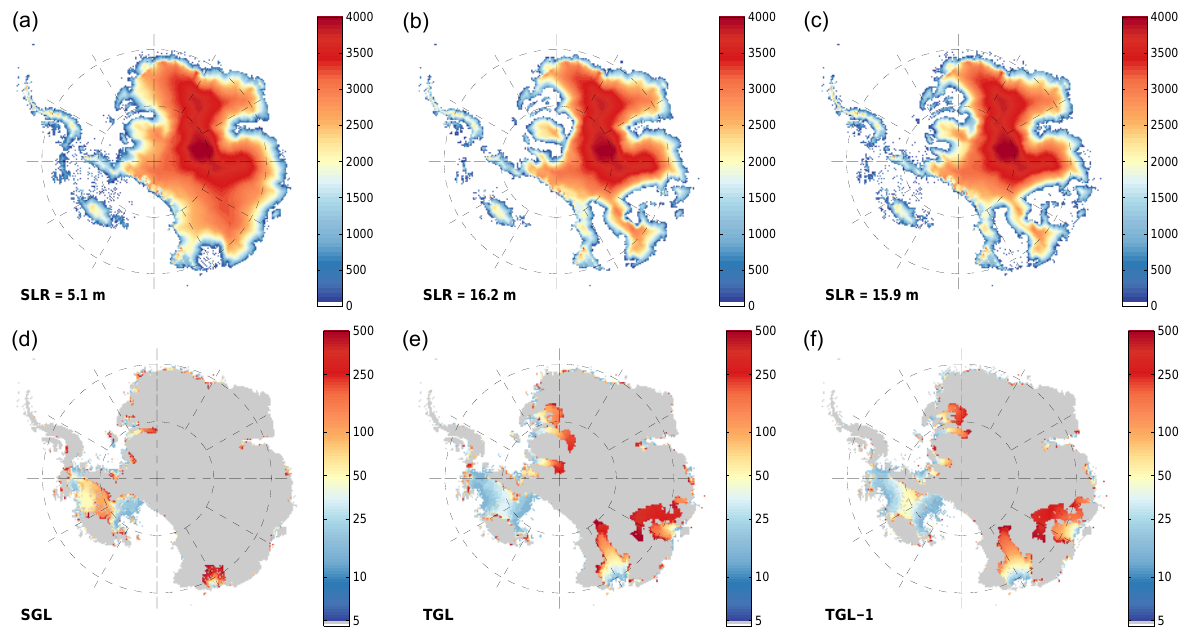
Figure 6. Top: grounded ice sheet surface elevation (ma.s.l.) 500 years after sudden removal of all ice shelves. Bottom: grounding-line position in time according to the same experiment (colour scale is non-linear and represents time in years) for the Weertman sliding law with SGL condition (left), Coulomb friction law with TGL condition (centre), and Weertman sliding law with TGL condition (right). SLR denotes the contribution to sea-level rise after 500